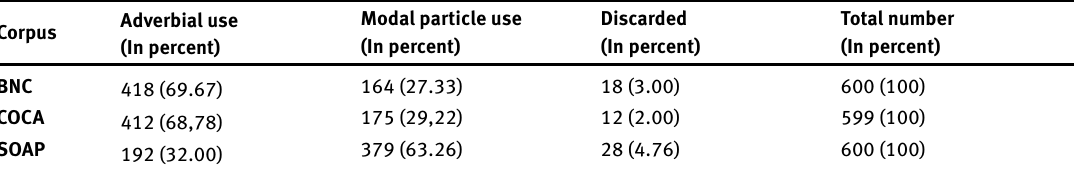
Table 9: Distribution of modal particles uses of just across corpora